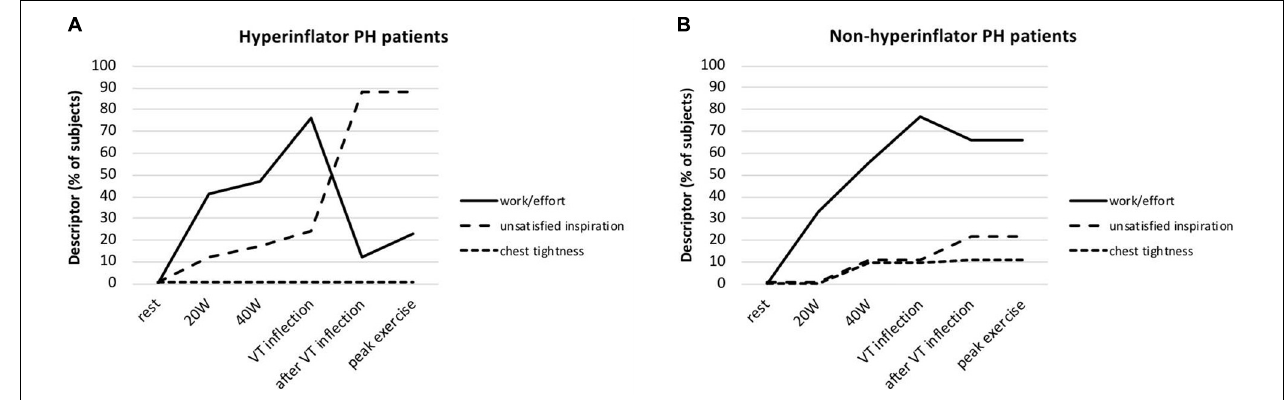
FIGURE 6 | (A) Selection frequency of the three descriptor phrases evaluated during symptom-limited incremental cycle exercise in patients with pulmonary hypertension (PH) who hyperinflate (Hyperinflators) during exercise: increased work/effort, unsatisfied inspiration, and chest tightness. Data are presented as mean at rest, at 20W (iso-WR 1), at 40 W (iso-WR 2), at the tidal volume (VT) inflection point, after the VT inflection point and at peak exercise. (B) Selection frequency of the three descriptor phrases evaluated during symptom-limited incremental cycle exercise in patients with pulmonary hypertension (PH) who deflate (Non-hyperinflators) during exercise: increased work/effort, unsatisfied inspiration, and chest tightness. Data are presented as mean at rest, at 20W (iso-WR 1), at 40 W (iso-WR 2), at the tidal volume (VT) inflection point, after the VT inflection point and at peak exercise. Reproduced with permission of Boucly et al. (2020).